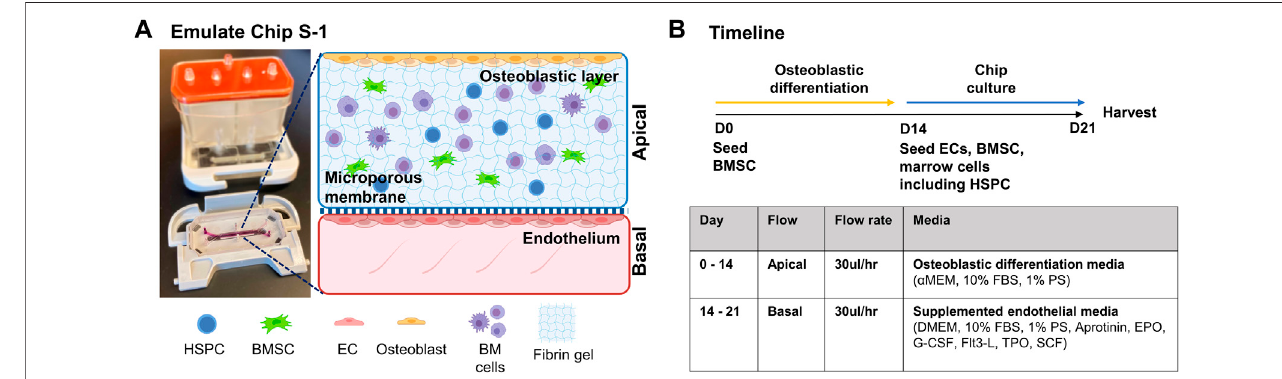
FIGURE 1 | BMME-on-chip with osteoblastic, endothelium layer and whole bone marrow cells. (A) Diagram of BMME-on-chip and (B) culture timeline. Illustrated using Biorender.com.